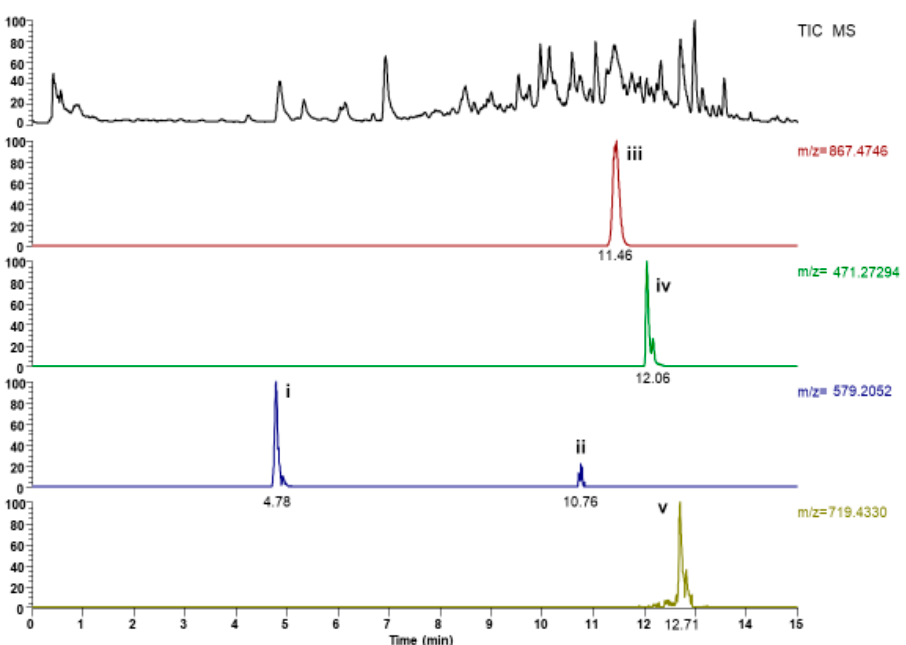
Figure 1. Chromatograms of the extracts from D. hispida analyzed by UHPLC. (i and ii) (+)syringavesinol-4- O - β - D -glucopyranoside-isomer (iii) Dioscin (iv) Diosgenin-3-6-dione (v) Progenin III.